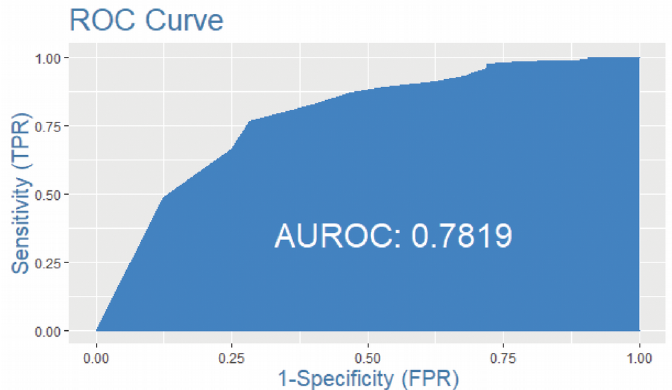
Figure 1. ROC curve of the logistic regression